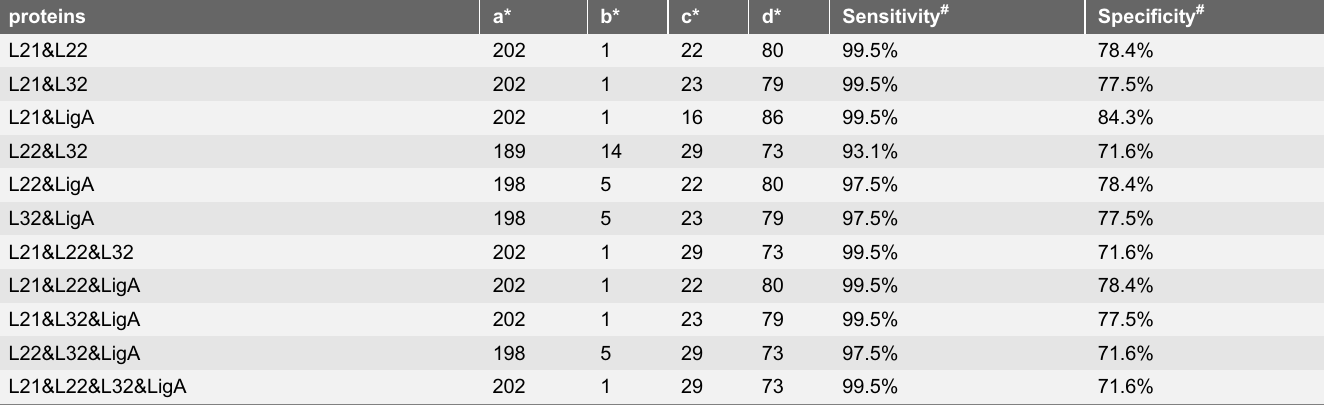
Table 4. Sensitivity and specificity of the ELISA test.